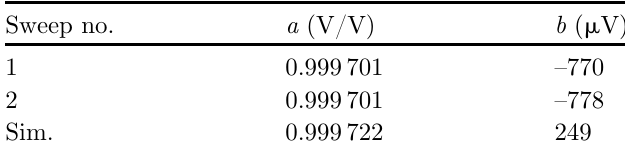
Table 2. Results form the linear regression of the two dc sweeps. The parameters a and b represent gain and offset respectively.